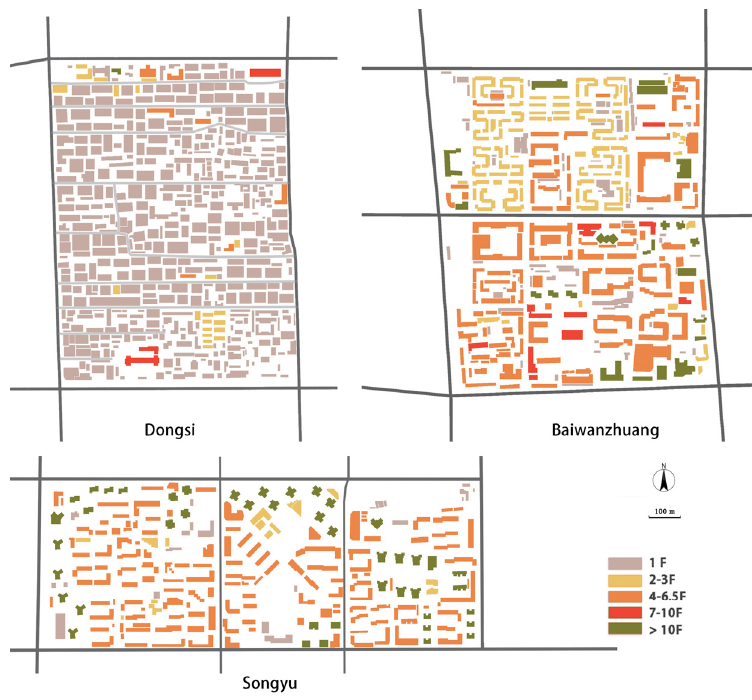
Figure 6. Building heights in the neighborhoods.